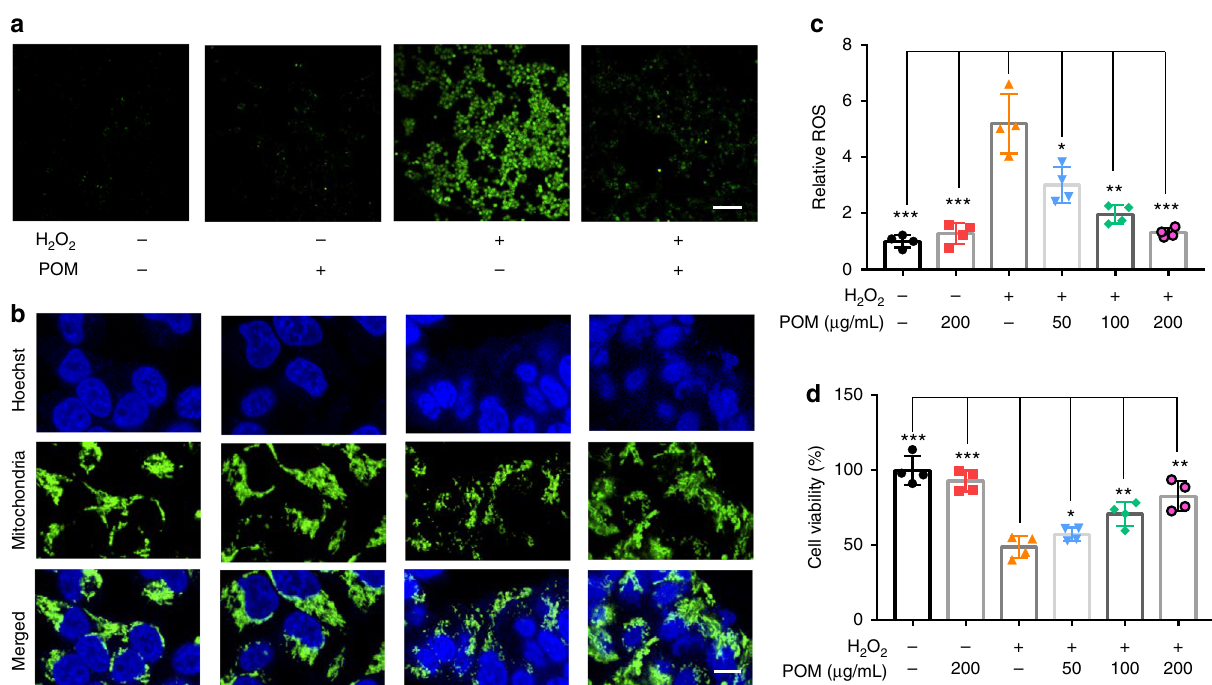
Fig. 2 Scavenging ROS with POM nanoclusters in vitro. a Representative ROS staining of HEK293 cells under different treatment conditions. Scale bar: 50 μ m. b Representative mitochondria staining of HEK293 cells under different treatment conditions. Scale bar: 5 μ m. c ROS levels in untreated and POM- treated HEK293 cells incubated with 0.25 mM H 2 O 2 . d In vitro cell viabilities of HEK293 cells under different treatment conditions. In c and d , data represent means± s.d. from four independent replicates, and P values were calculated by two-tailed Student ’ s t -test (* P < 0.05; ** P < 0.01; *** P <